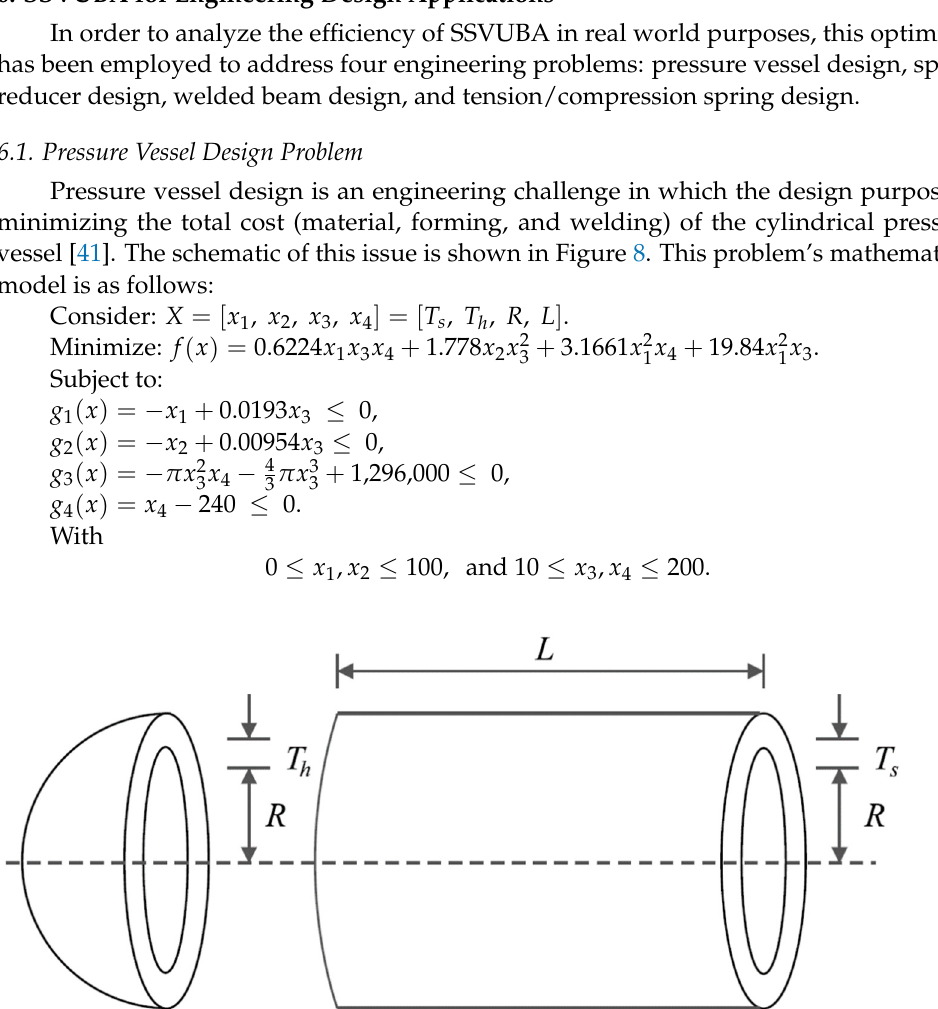
Table 10. Performance of optimization algorithms in the pressure vessel design problem.